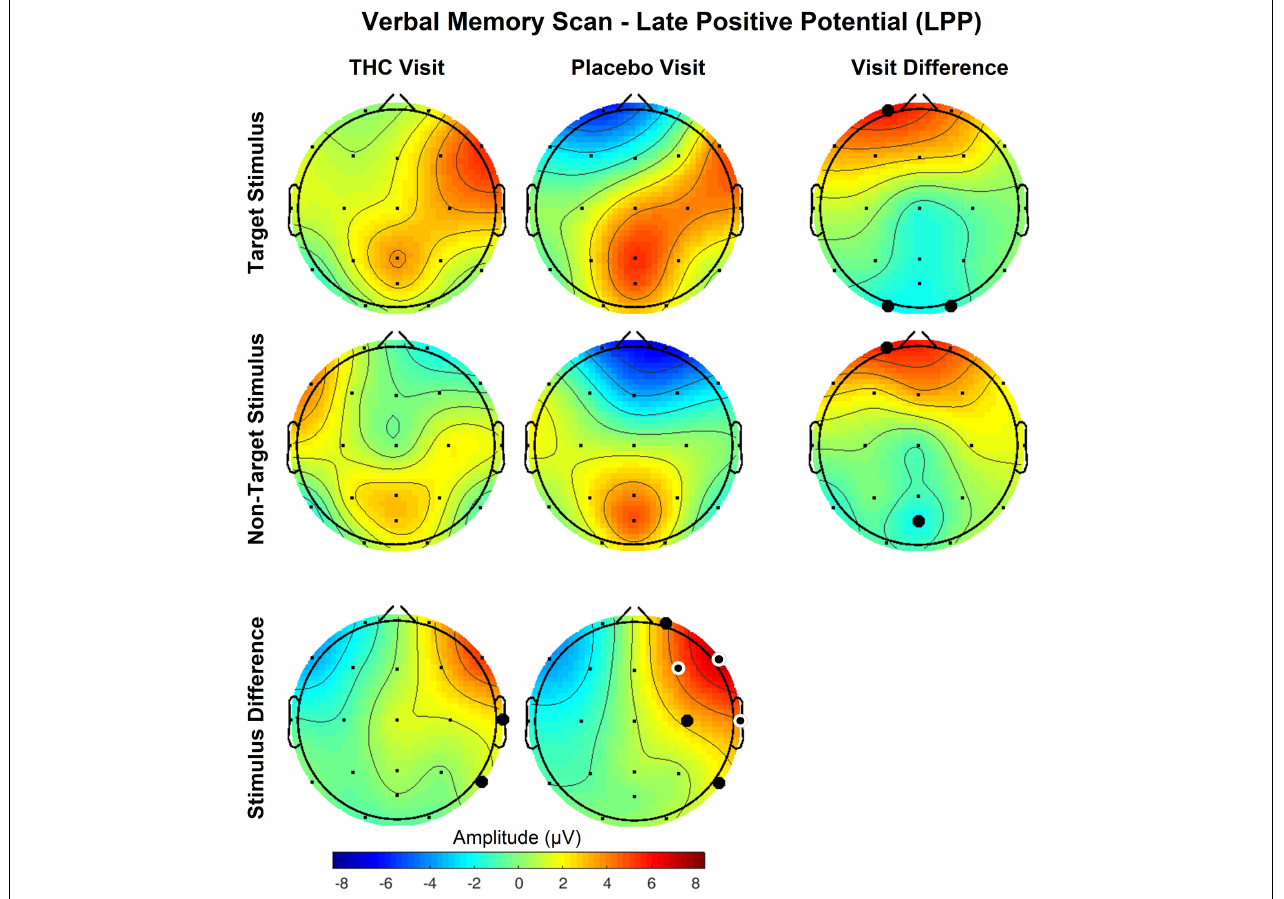
FIGURE 6 | Verbal memory scan, late positive potential by visit and stimulus. Significant differences in LPP were found both between visits and between stimuli. Effects of visit read horizontally across figure; effects of stimulus are arranged vertically. Differences between Target and NonTarget stimuli were significantly elevated over right frontal and central channels during placebo visit. These differences all but disappeared during THC visit. Filled black circles mark significant channels before FDR correction for multiple comparisons; white rings indicate channels that remained significant after FDR correction for multiple comparisons. Numerical results of statistical analysis in Tables 3 , 4